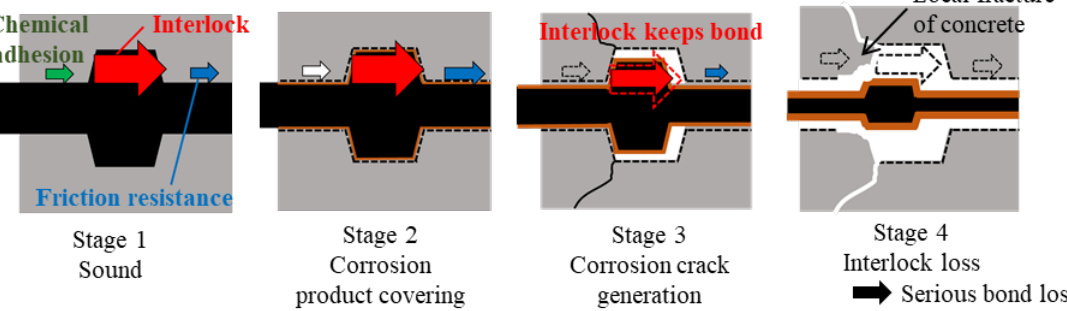
Figure 18. Interlock loss progress on a lug with corrosion.